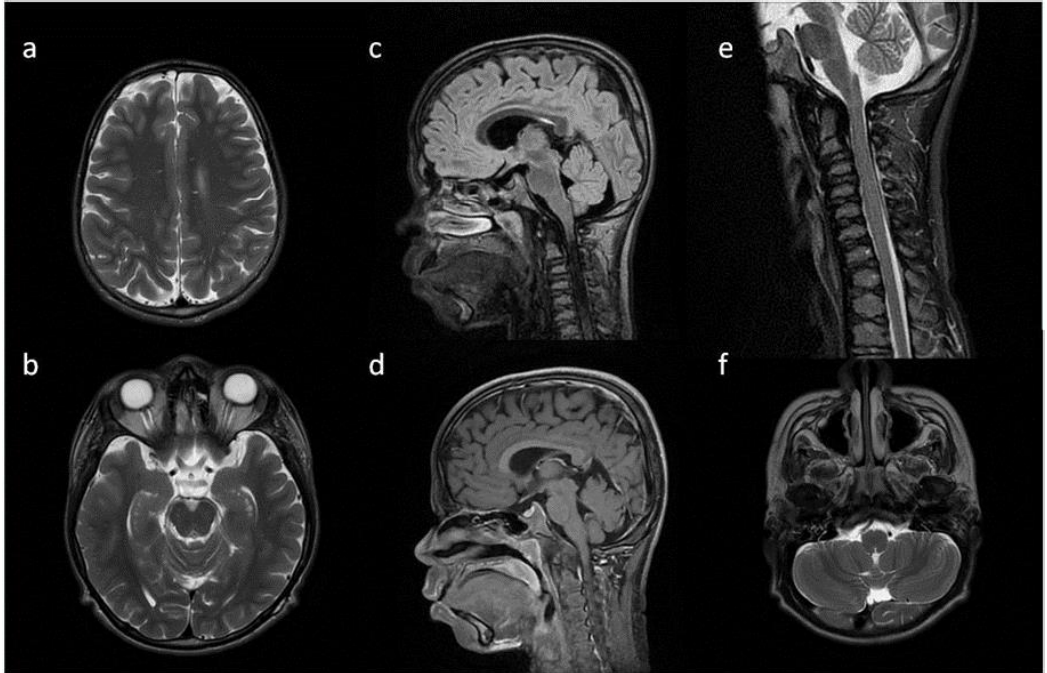
Figure 6. Brain and spine MRI. Patient 5. ( a , b , f ) axial T2; ( c , d ) sagittal brain; ( c ) T2 FLAIR; ( d , g ) T1; ( e ) sagittal spine; ( e ) T2; Findings: ( a ) enlarged PVS with characteristic location in corpus callosum; ( b ) optic nerve sheath enlargement; ( c , d ) flattened anterior border of sella turcica, dysplastic dens; ( f ) mastoid cells fluid; ( e ) vertebral and intervertebral discs deformation, cervical spine kyphosis and stenosis.